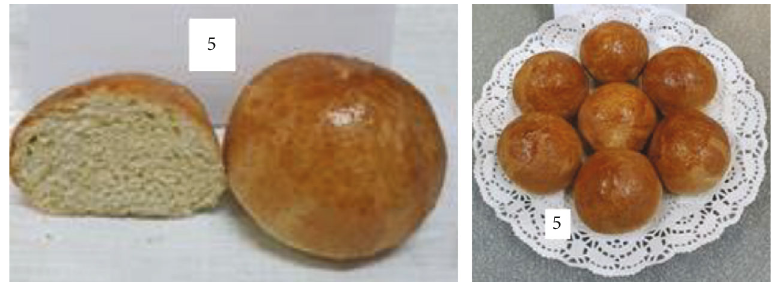
Figure 6: Sample no. 5 made from 15% fl our with sugar.